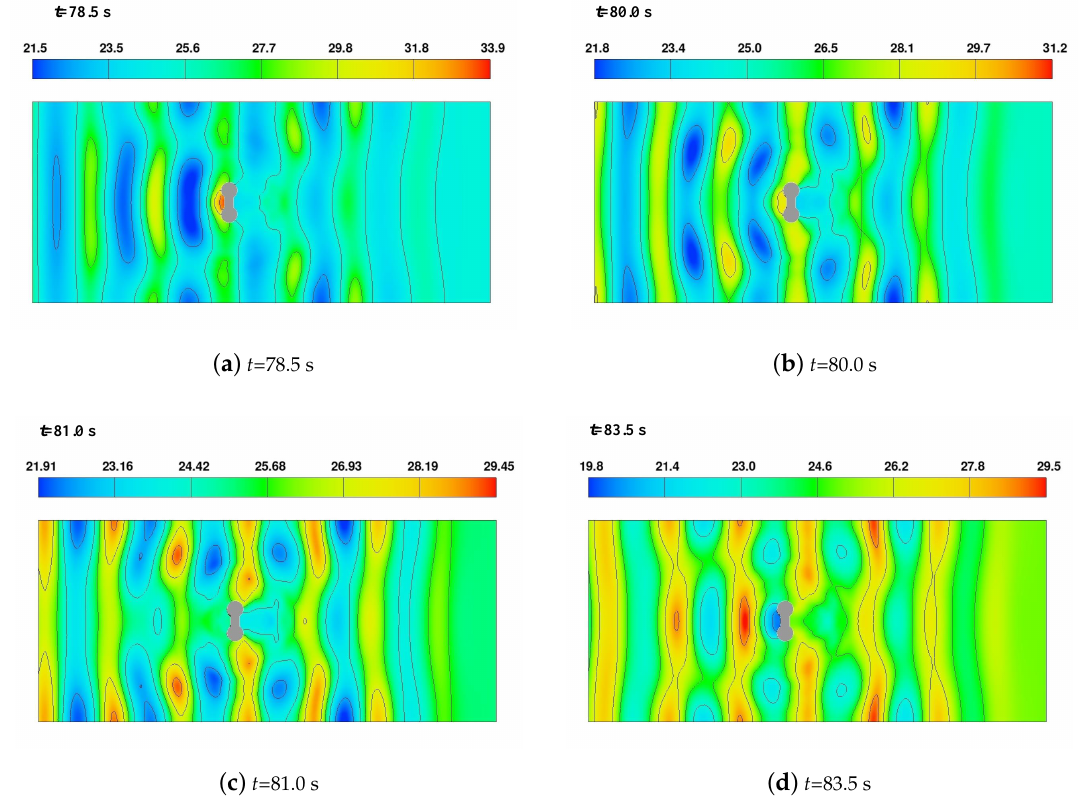
Figure 10. Snapshots of wave propagation (the curves in the figure are the contour lines of the free water surface. Unit: